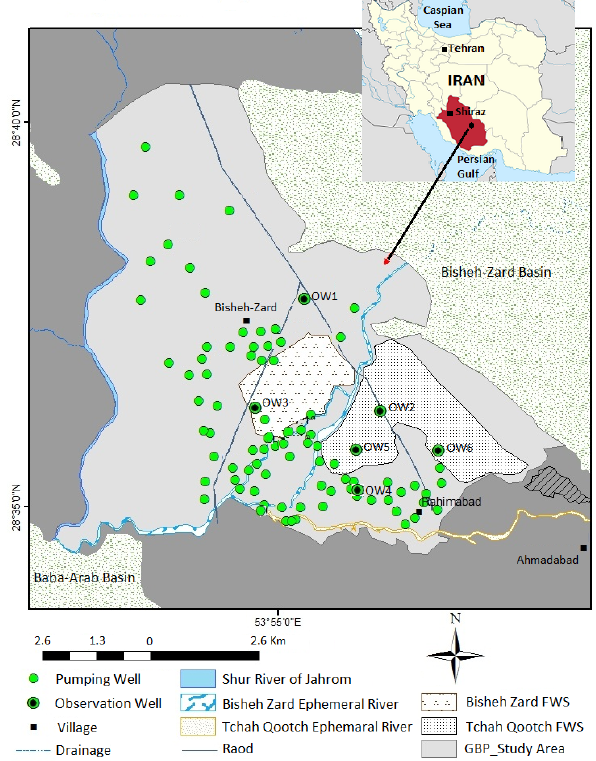
Figure 1. Location of the floodwater spreading systems, observa- tion wells, pumping wells, and river networks within the studied